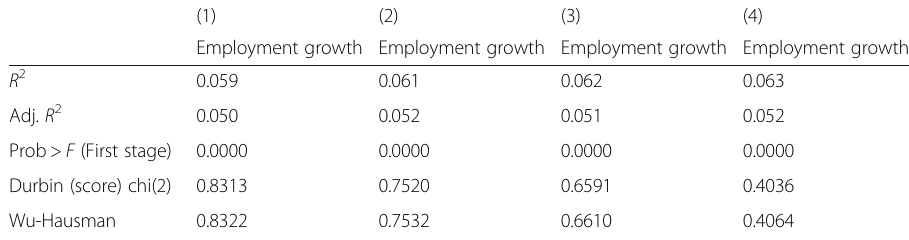
Table 8 Instrumental variables (2SLS) regressions